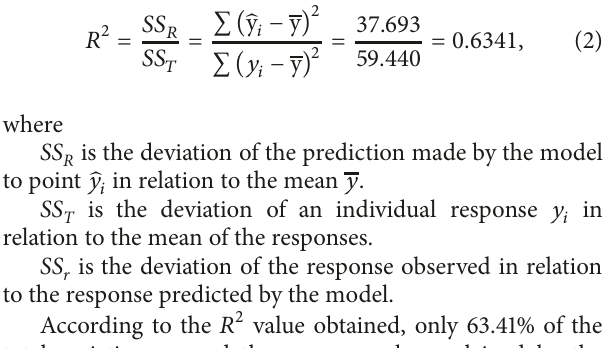
Table 3: Analysis of variance for quadratic model adjusted to data set of Table 2. Variation